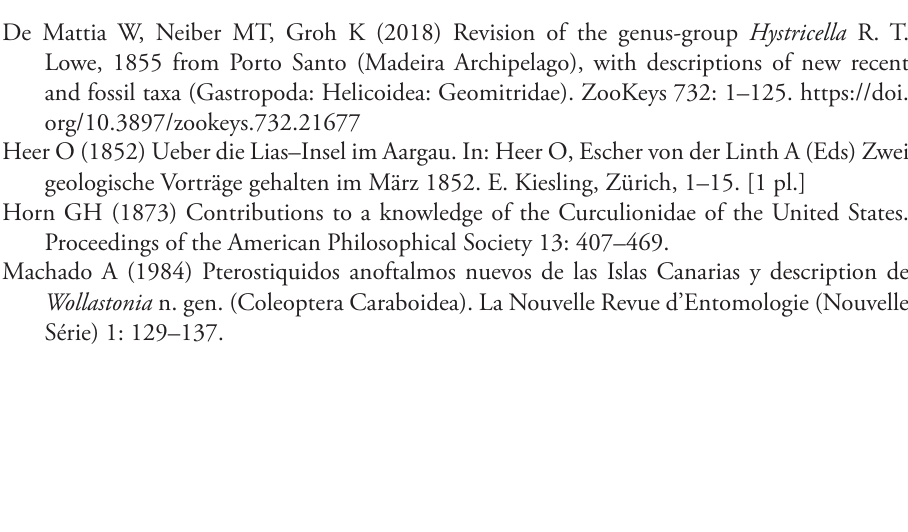
Fig. 15 should read Caseolus ( Leptostictea ) leptosticus , Ponta do Garajau, Madeira. Fig. 16 should read Caseolus ( Helicomela ) punctulatus punctulatus , Fonte da